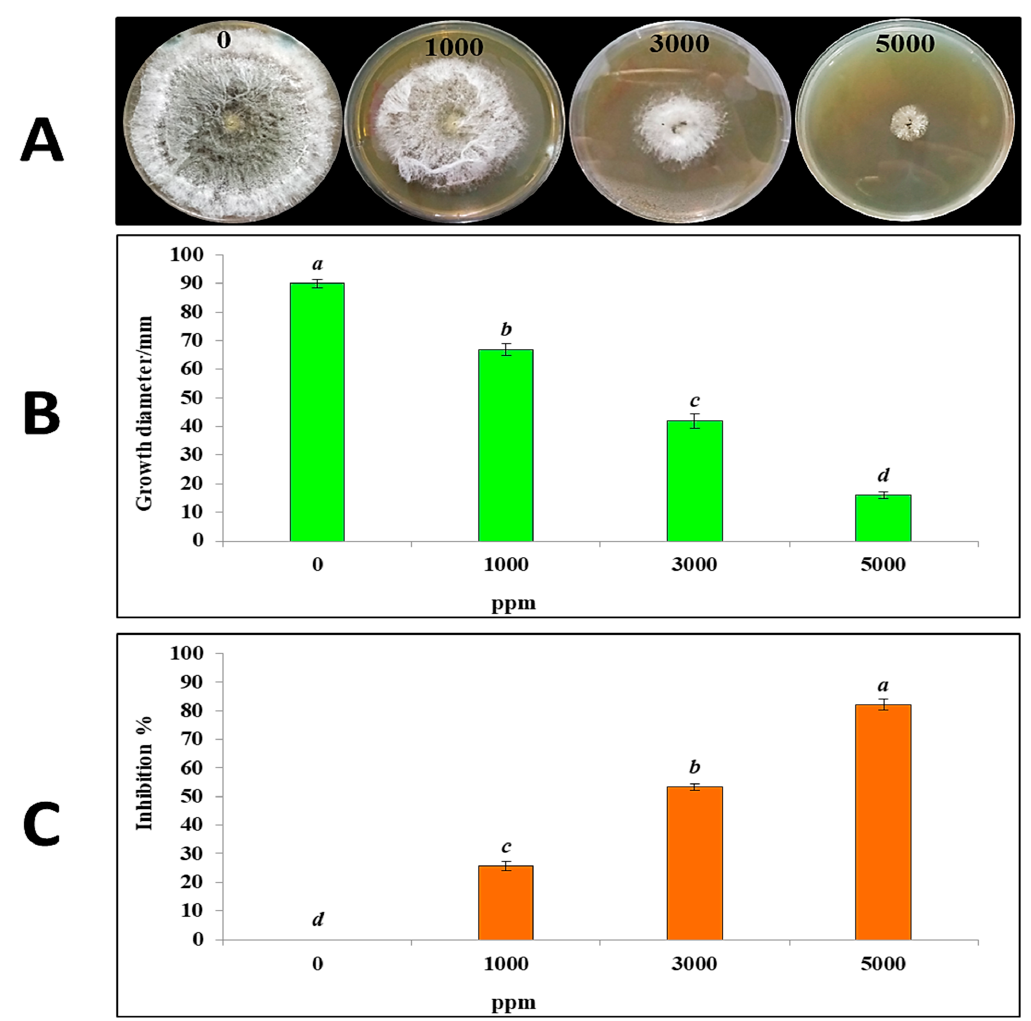
Figure 5. E ff ect of di ff erent concentrations of CEONE on radial growth ( A , B ), and inhibition % ( C ) of N. dimidiatum . Le tt ers a,b,c,d mean power of signi fi